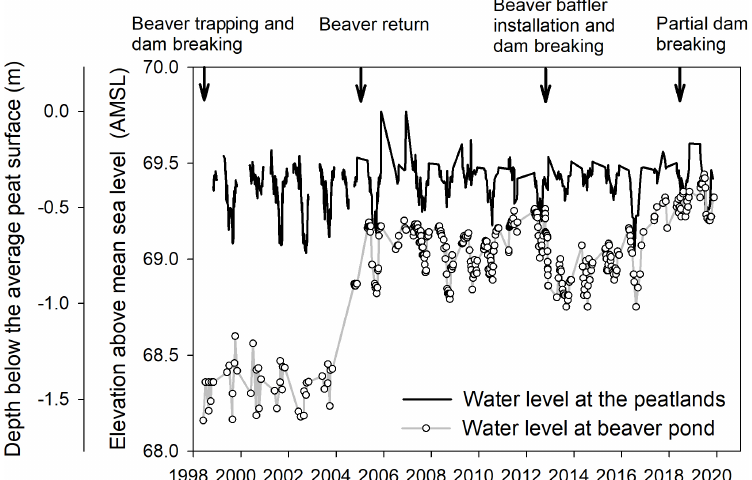
Figure 2. Measured water level at the peatlands and the BP over 1998–2019. The arrows indicate the disturbance of the BP dam by human management (personal communication from Eva Katic, 2020, NCC). Note that part of the 1999–2003 BP water level data are generated by using available measured data, see Sect. A for more details in the